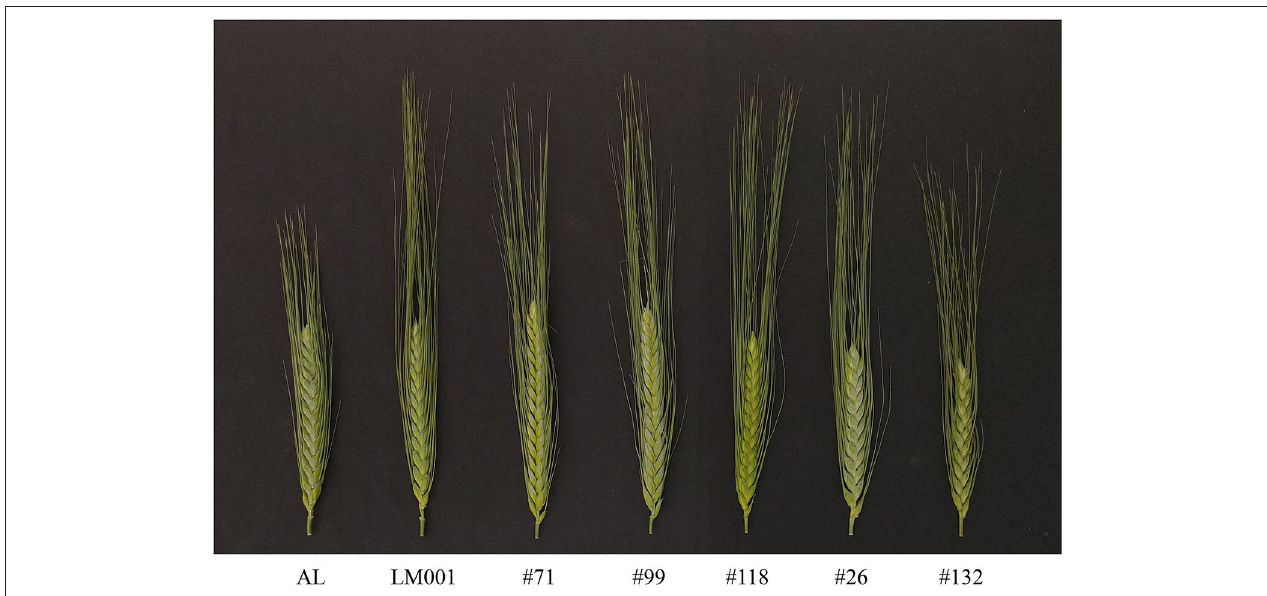
FIGURE 1 | The spike morphology of the parents and representative lines from the AM population (scale bar = 2